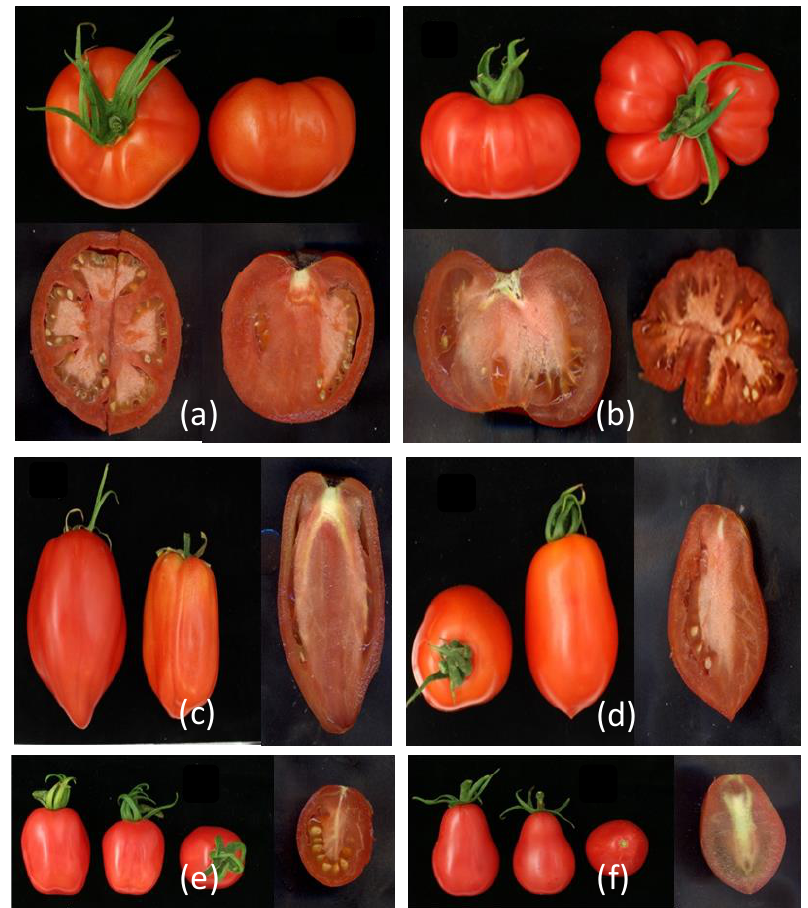
Figure 10. Examples of accessions with fruit shape mutations in our collection. ( a ) RF_096 with the lc mutation; ( b ) RF_041 with the fas mutation; (c) RF_024 with the sun mutation; ( d ) RF_214 with the ovate mutation; ( e ) RF_035 with the ovate mutation; and, ( f ) RF_043 with the sun and ovate mutations.